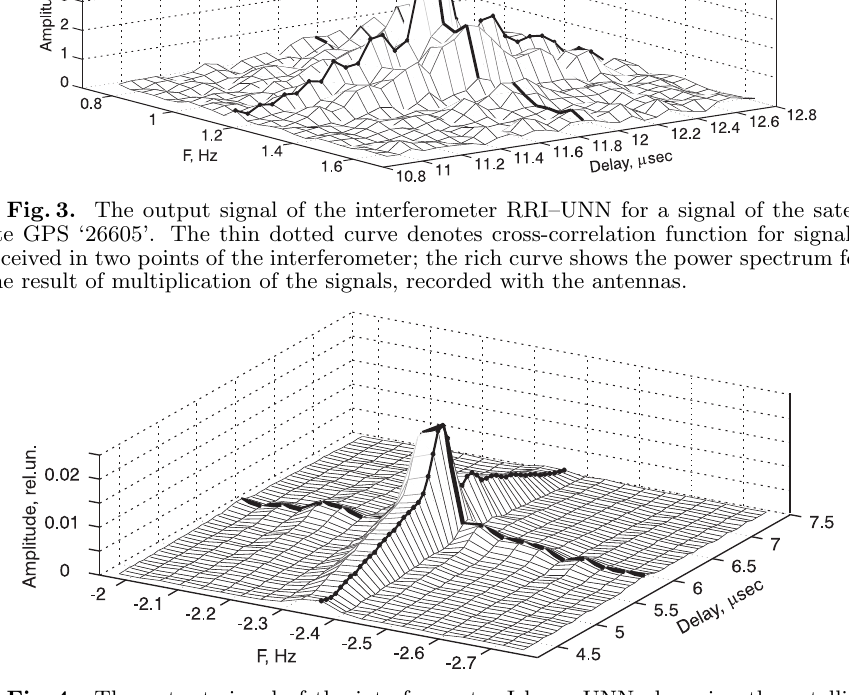
Fig. 4. The output signal of the interferometer Irbene{UNN observing the satellite GLONASS ‘37868’. pattern of the